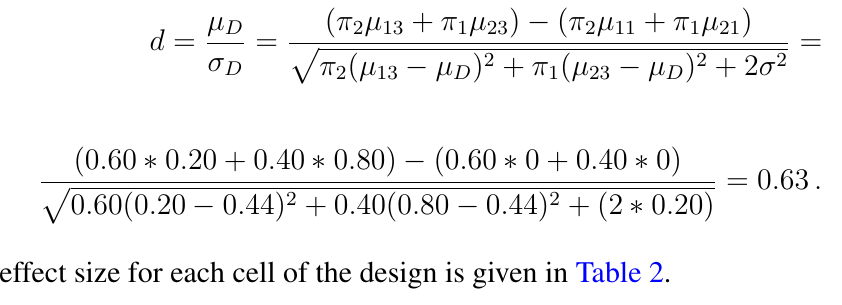
Table 2. Population effect size for each cell of the